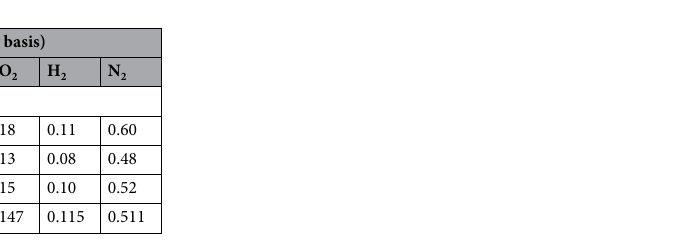
Figure 3. Time-dependent mole fractions of product gases at different mesh sizes (dx and dy in mm) for validation with experimental data of Gerber et al. 30 .